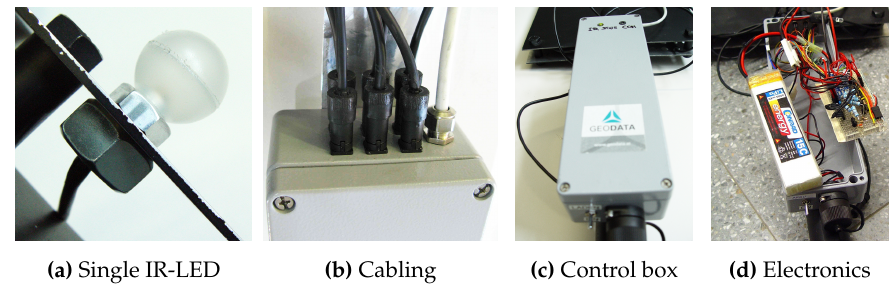
Figure 13. Details of the developed target